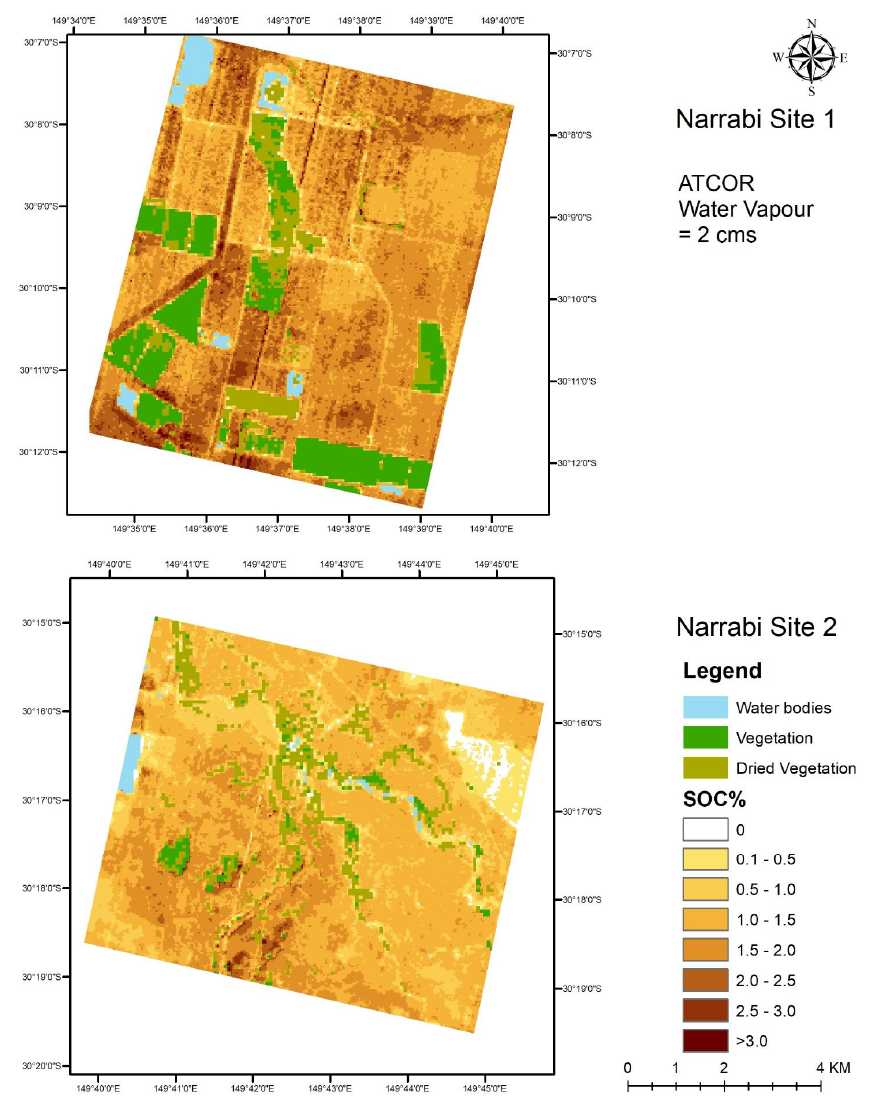
Figure 12. SOC prediction maps using WV of 2cm with ATCOR method.